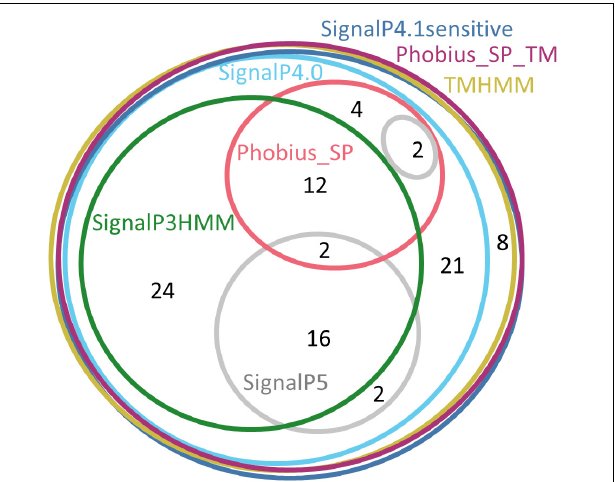
FIGURE 2 | Euler diagram representing the overlap of positive signal peptide predictions between predictors for all SBP sequences. The numbers indicate counts of sequences. Each software package has been associated with a specific color. As it was not possible to produce a strict Euler diagram, the SignalP5 ellipse was split into two